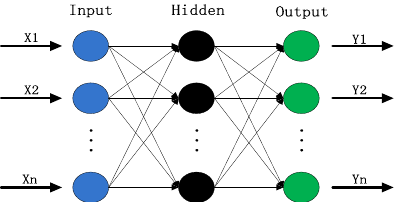
Figure 1. Topological structure of the BP network which includes only one layer of the hidden layer.